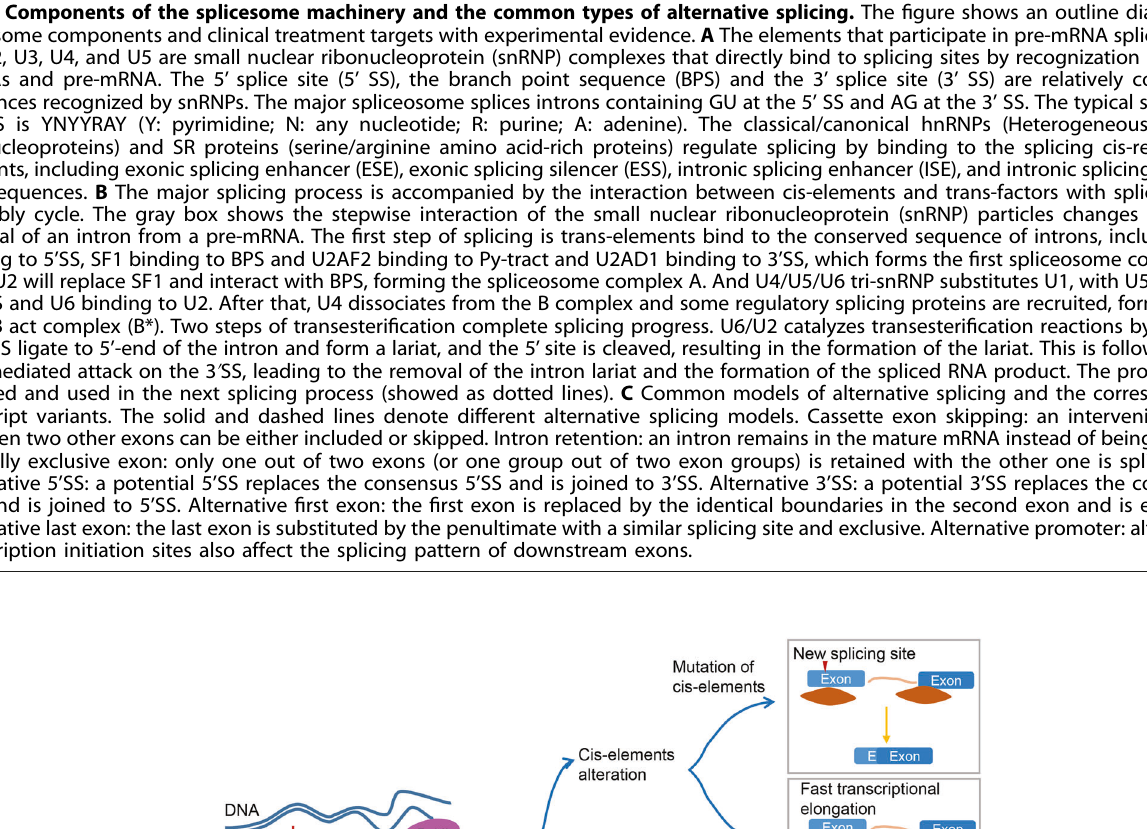
Fig. 2 The mechanism of aberrant splicing in colorectal cancer. The diagram shows the classi fi able explanation of abnormal splicing in CRC. Splicing occurs co-transcriptionally on nascent RNA, which is attached to chromatin by RNA polymerase II (showed in the left fi gure). Both alterations of cis-elements and trans-regulatory factors would cause abnormal splicing events and products. New recognized sites are created by mutation of cis-elements like single base substitutions, translocation, and alternative promoters (the fi rst diagram on the right). Alteration of chromatin would in fl uence af fi nity between splicing factors to splicing sites by conformational change or speed of transcription elongation with changed time of splicing factors loading on cis-elements (the second diagram on the right). In addition, the expression and post- modi fi cation of trans-regulatory alter the splicing by infecting recognization between splicing factors and splicing sites. prominent promoter 2 of hepatocyte nuclear factor 4 alpha K (lysine) acetyltransferase 2B (KAT2B) occupancy and histone3/4 (HNF4a), rather than promoter1, is transcribed into P2-HNF4a pre- acetylation nucleosome can increase exon 2 exclusion in myeloid mRNA with extra exon 1D and provides more splicing sites, which cell leukemia sequence 1 (MCL1) transcript variant [45]. Inhibition results in increased pro-proliferation HNF4a7/8 splice variants of HDAC resulted in hyperacetylation of H3K4me3 nucleosomes [47, 48]. and increased the rate of elongation through these regions, which did not leave suf fi cient time for the loading of SRSF1 onto exon 2. The absence of SRSF1 and other splicing factors at exon 2 resulted in increasing the MCL1 exon 2 exclusion [45]. And the trimethyla- tion of H3K36me3 accelerated transcription elongation and reduced the removal of intron 2 of disheveled segment polarity protein 2 (DVL2) [46]. In addition, different transcriptional initiation sites can alter splicing with additional splicing sequences. The Cell Death and Disease (2021)